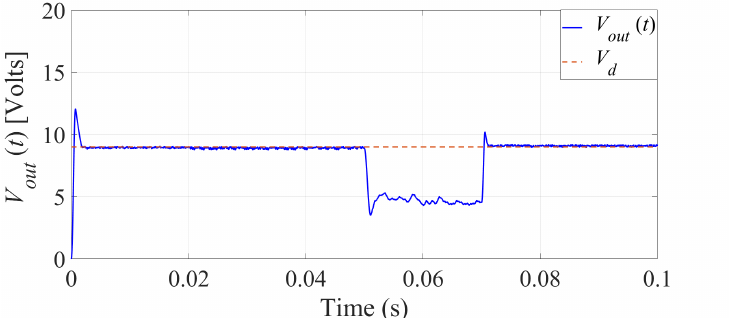
Figure 8. Scenario 1: Output voltage ( V out ( t ) ) implementing a classical PID controller (simulation 2).